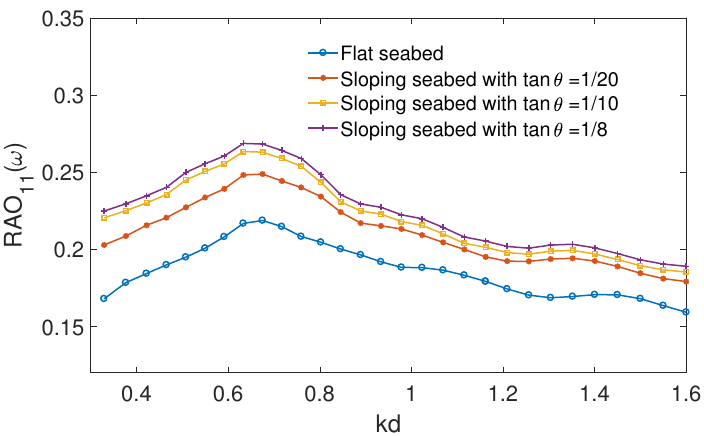
Figure 15. Comparison of the floating body surge motion RAO 11 ( ω ) between flat seabed, sloping seabed with tan θ = 1/20, tan θ = 1/10 and tan θ = 1/8, respectively with mooring line length L 1 = L 2 = 60